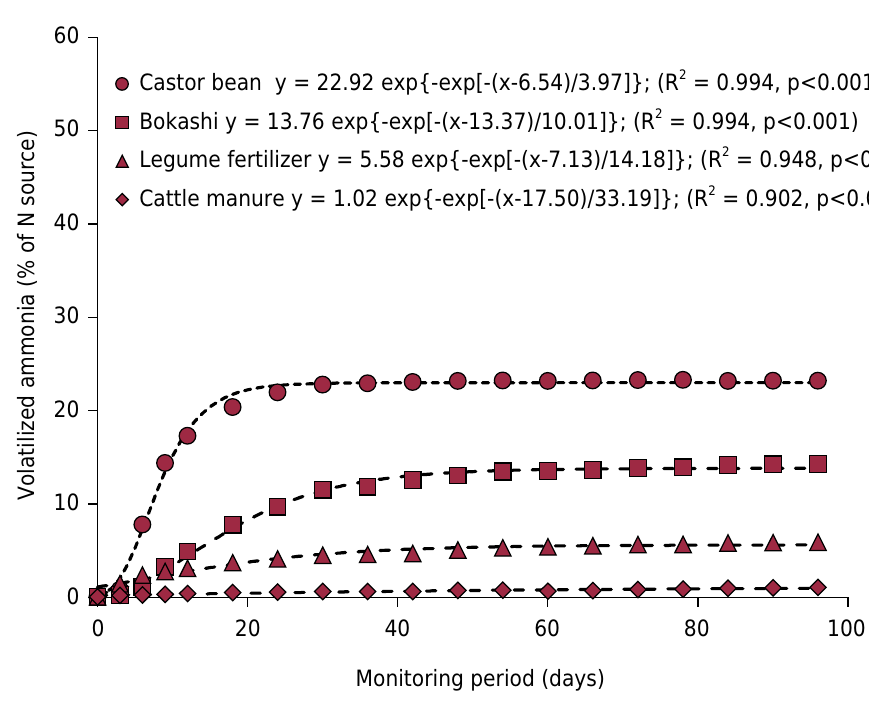
Figure 1. Ammonia volatilized from different surface-applied fertilizer sources (castor bean, bokashi, legume fertilizer and cattle manure) in snap bean cultivation, within 96